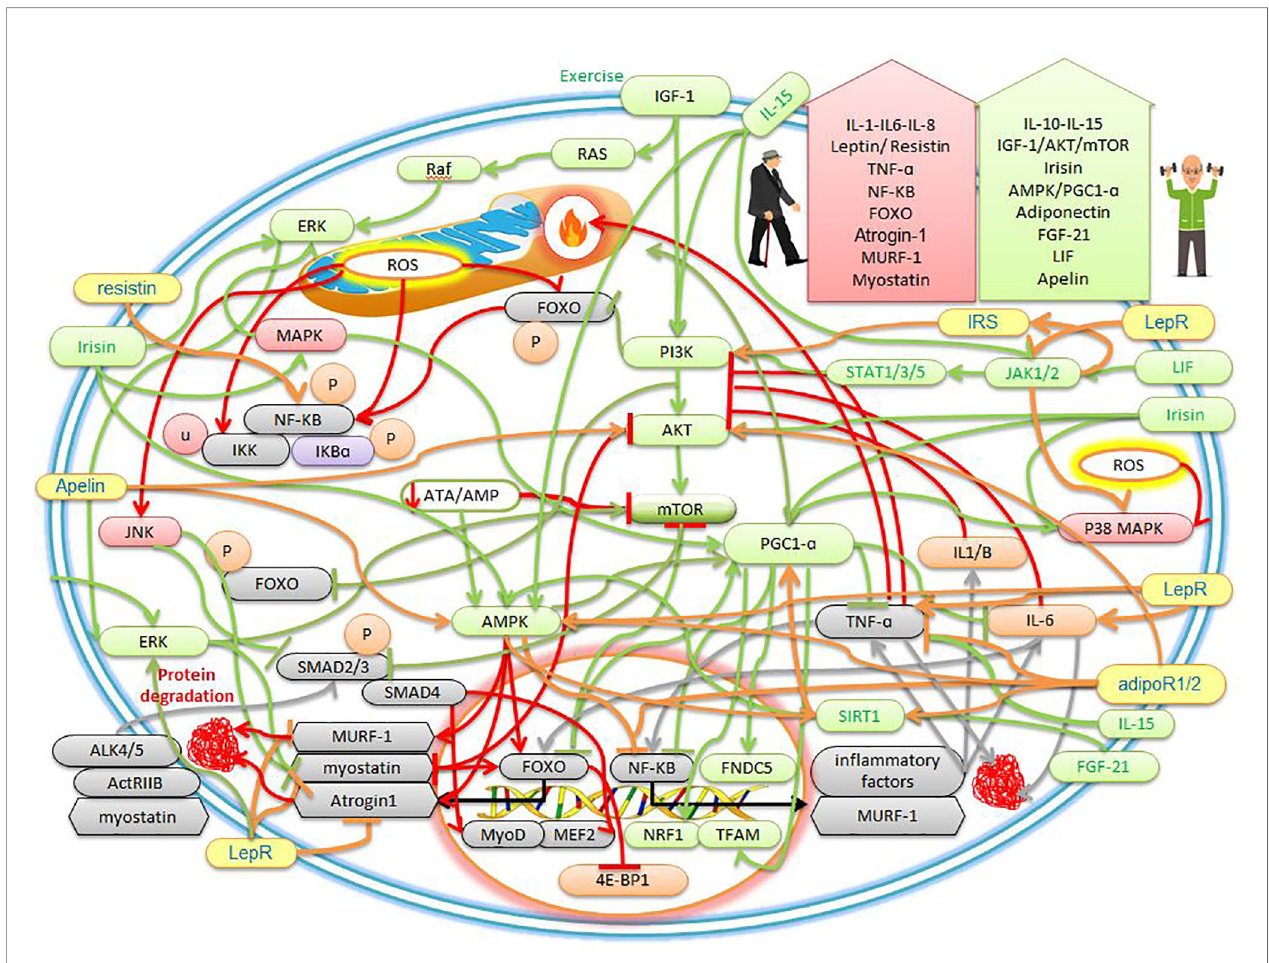
FIGURE 1 | The effects of sarcopenic obesity and exercise on the cellular mechanisms of myokines and adipokines. The description is available in the